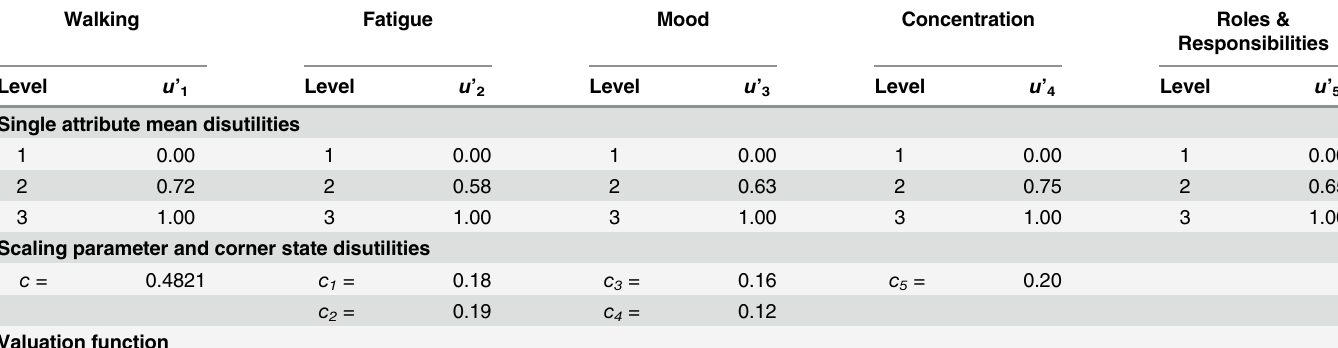
Table 6. PBMSI MAUF D developed based on standard gamble values obtained from the Development sample.